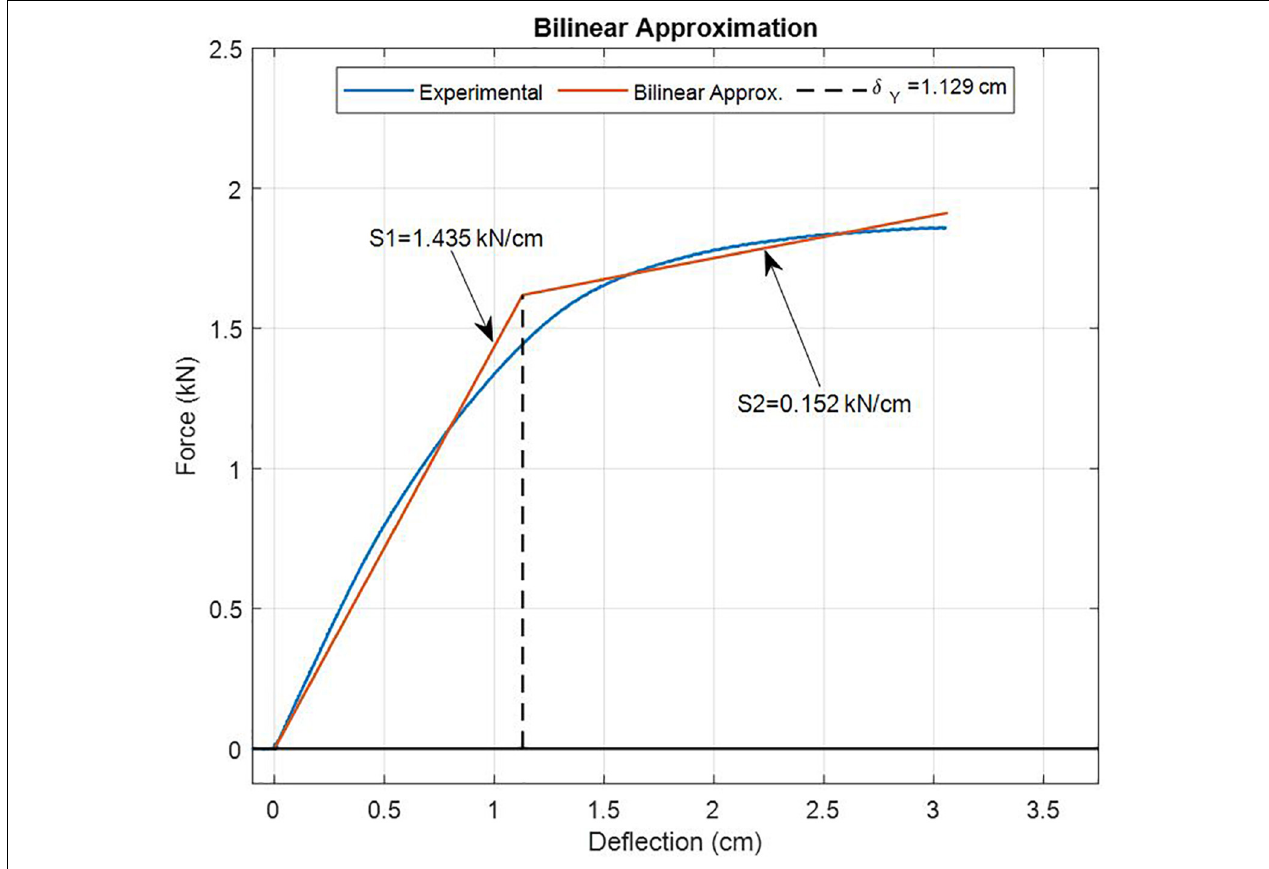
FIGURE 4 | Force-deflection behavior for steel beam substructure.